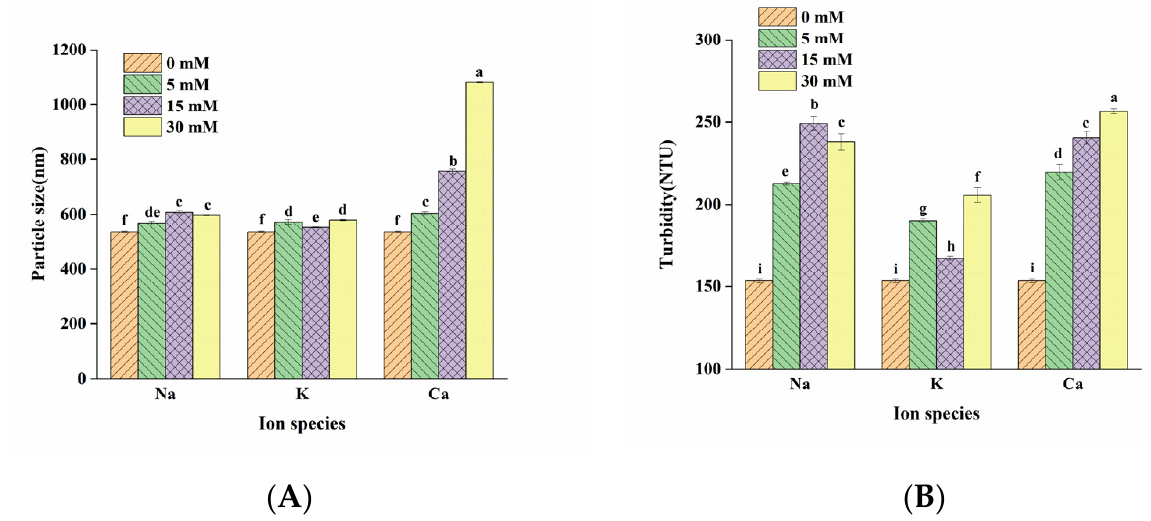
Figure 2. Effect of salt ion species and concentration on particle size ( A ) and turbidity ( B ) of the low methoxyl pectin/sodium caseinate (LMP/CAS) complex. Different letters above the bars indicate a significant difference ( p < 0.05).